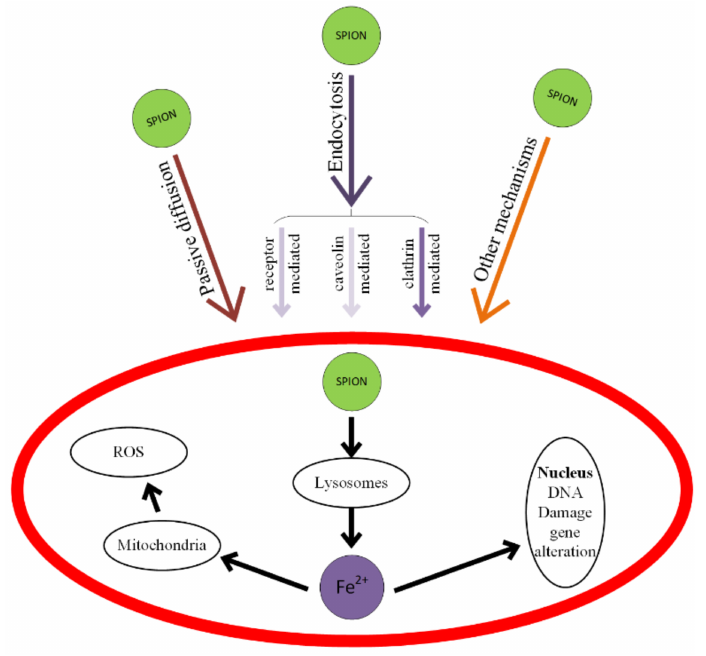
Figure 17. Mechanisms of SPIONs’ interaction with cells and types of induced toxicity. SPIONs mainly interact with cells through passive diffusion or endocytosis. The endocytosis pathways are: clathrin-mediated, caveolin-mediated and other